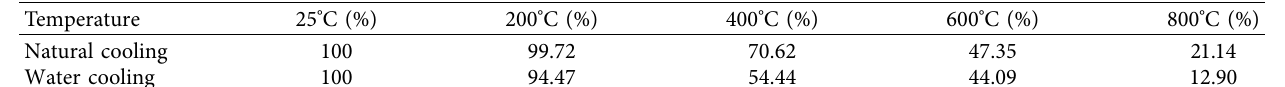
Table 6: Peak stress rate of change with